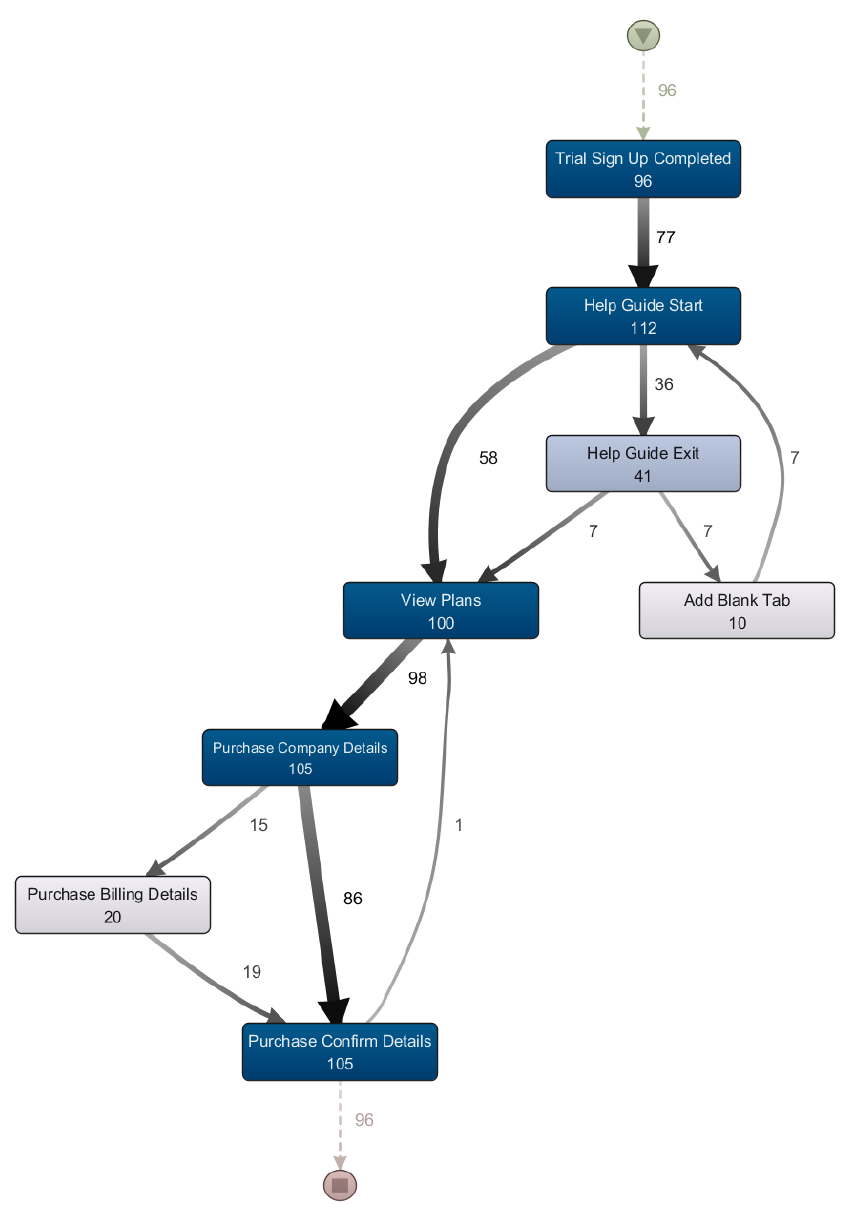
Figure 5. Process map for users who converted to customers within 5 min, generated with Disco from an event log with 96 cases and 30